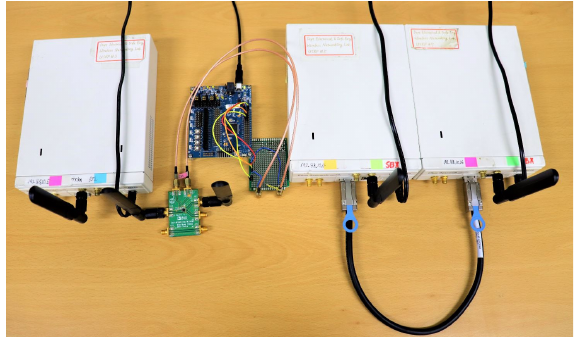
Figure 9. Hardware peripherals for testbed